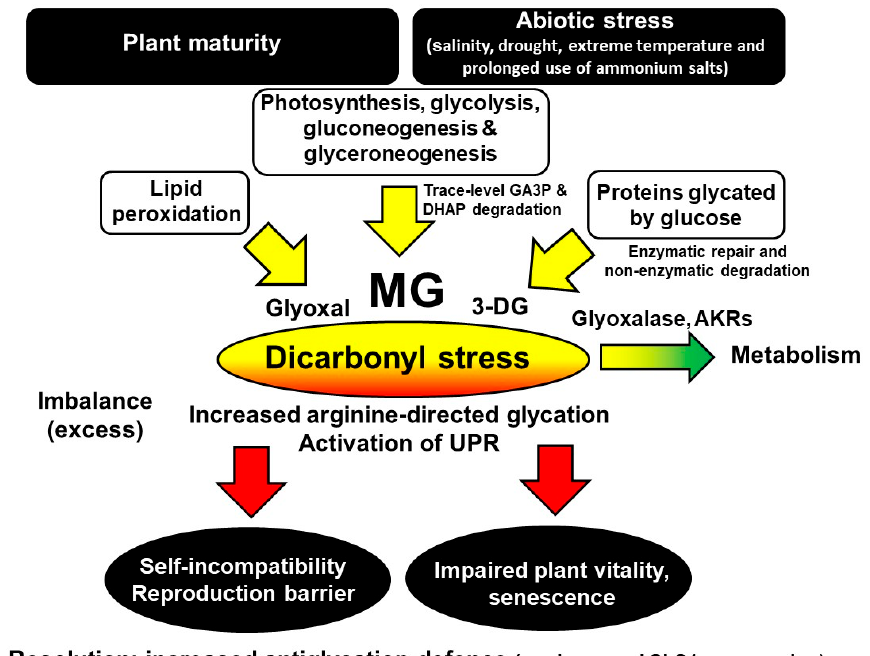
Figure 2. Metabolic drivers, pathophysiological effects and a strategy for the resolution of dicarbonyl stress in plants.